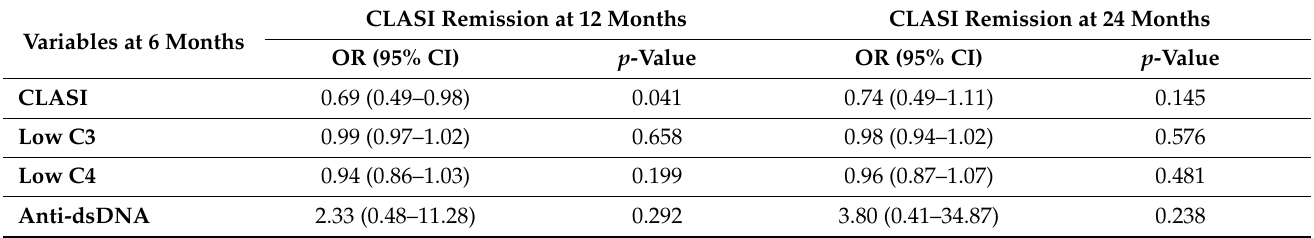
Table 6. Six-month predictors of long-term cutaneous remission in patients with partial response to